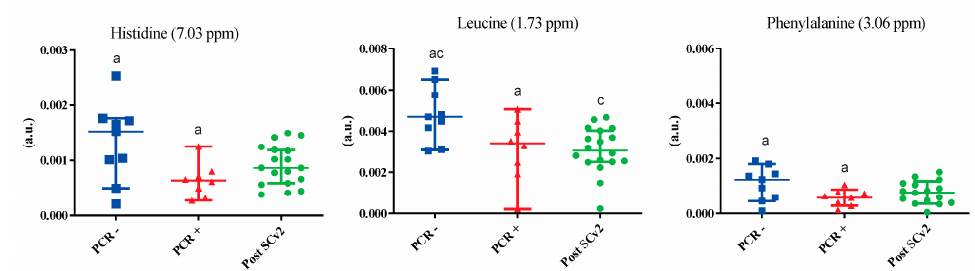
Figure 3. Amino acids that presented statistical differences ( p < 0.05) in the univariate analysis for the groups PCR − , PCR+, and post-SARS-CoV-2 infection (post-SCv2). The metabolites that presented statistical differences in the univariate analysis (Supplementary Figure S1) are indicated using letters; the same letter indicates a statistical difference.